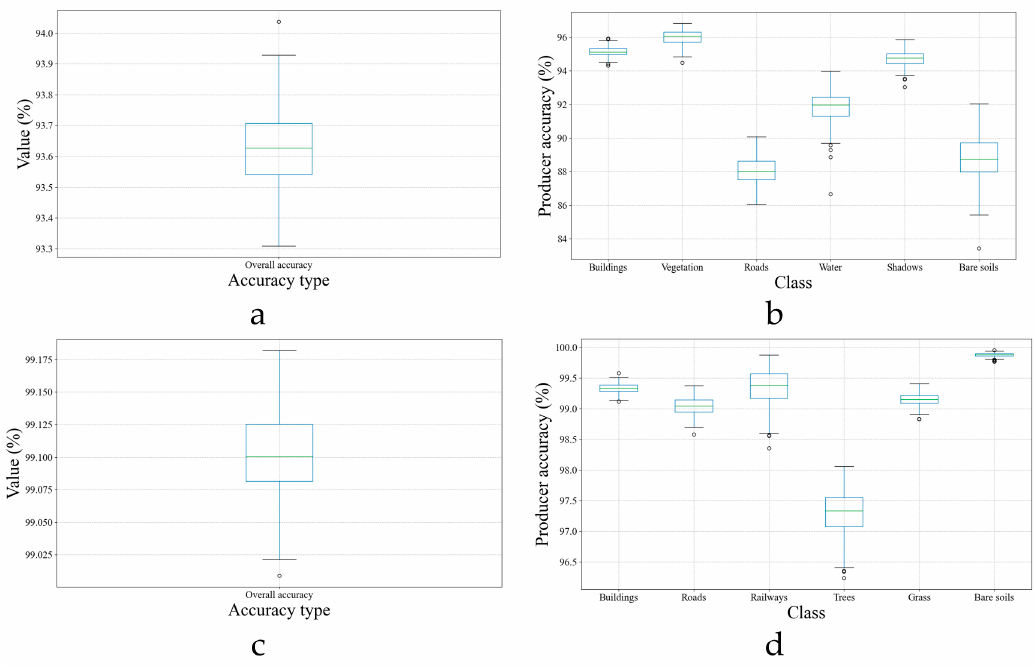
Figure 10. The box plots of classification accuracies. ( a ) The box plot of overall accuracy of Beijing dataset; ( b ) the box plot of producer accuracy of Beijing dataset; ( c ) the box plot of overall accuracy of Zurich dataset; ( d ) the box plot of producer accuracy of Zurich dataset.